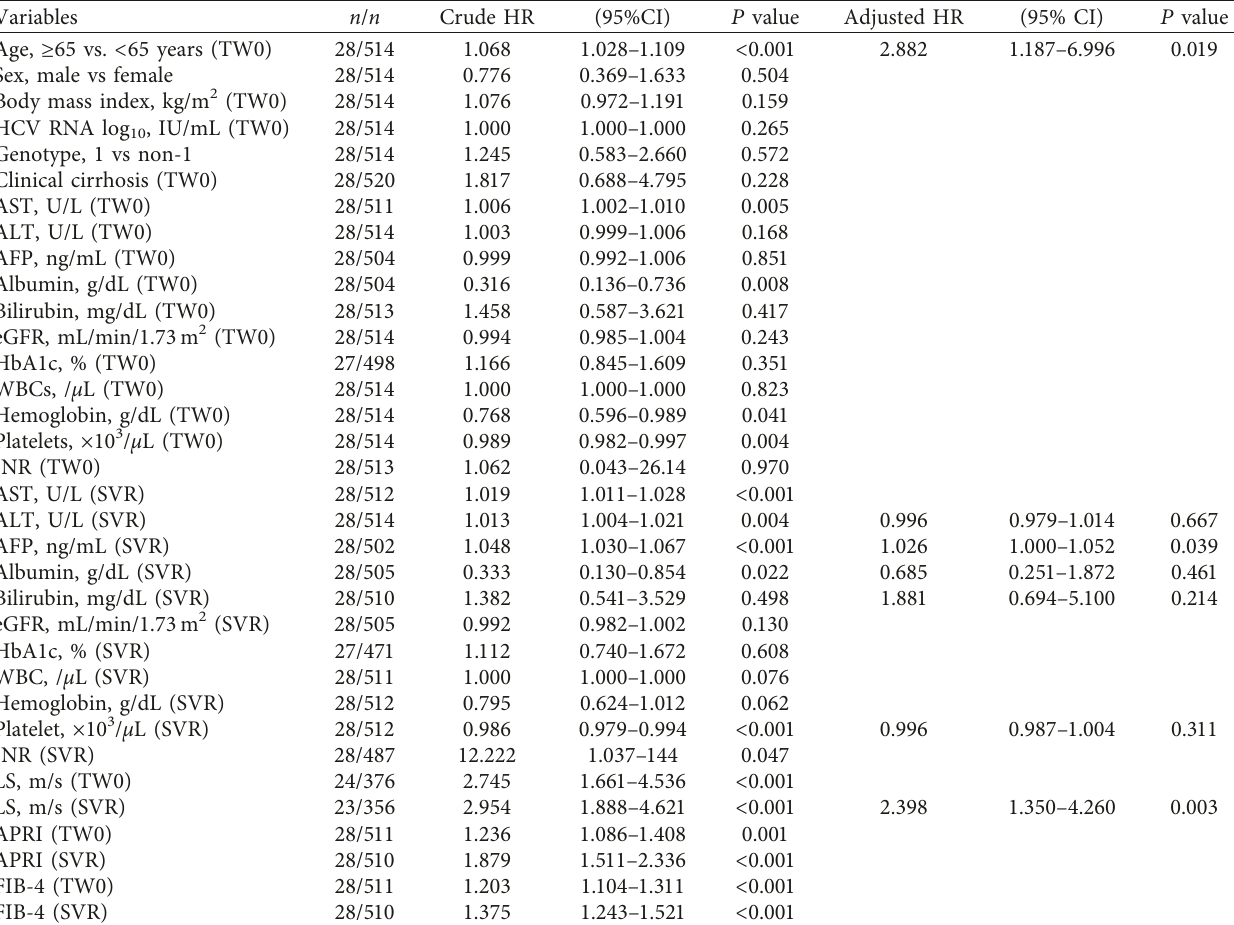
Table 2: Cox regression analysis for prediction of LREs ( n � 23, multivariate analysis) after a sustained virologic response.